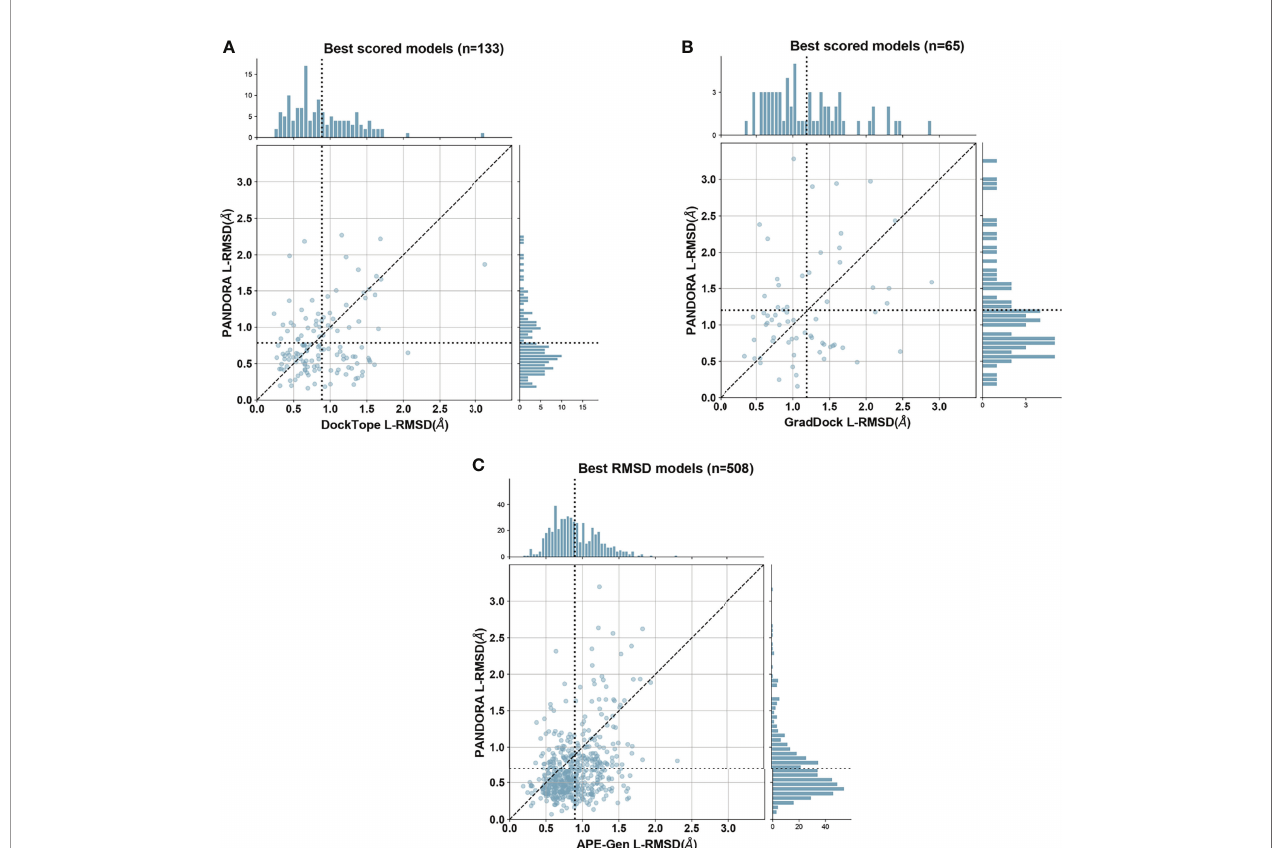
FIGURE 3 | PANDORA comparison with the state-of-the-art methods. Y axes represent PANDORA L-RMSD per case while X axes represent the L-RMSD of the same case modelled with the reported method. The dotted line indicates the average L-RMSD for each method. (A) Difference between PANDORA best molpdf model C a L-RMSD and DockTope reported C a L-RMSD on 133 cases (PANDORA cross-docking against DockTope cross-docking); (B) Difference between PANDORA best molpdf model backbone + C b L-RMSD and GradDock reported backbone + C b L-RMSD on 65 cases (PANDORA cross-docking against GradDock cross-docking); (C) Difference between PANDORA best L-RMSD model C a L-RMSD and APE-Gen reported C a L-RMSD on 509 cases (PANDORA cross-docking against APE-Gen